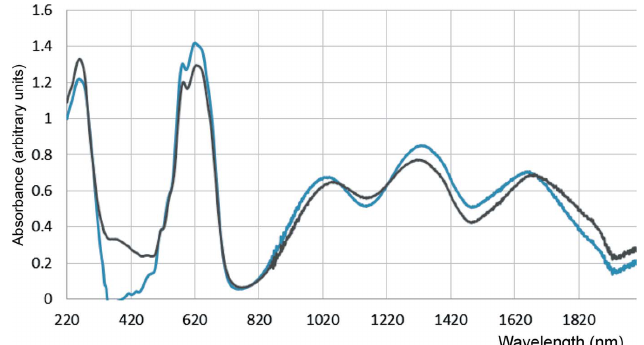
Figure 6 Solid-state diffuse reflectance spectra of [Co 2 (Ppz)Cl 4 ] (blue trace) and Co(Pmhpz)Cl 2 (black trace).